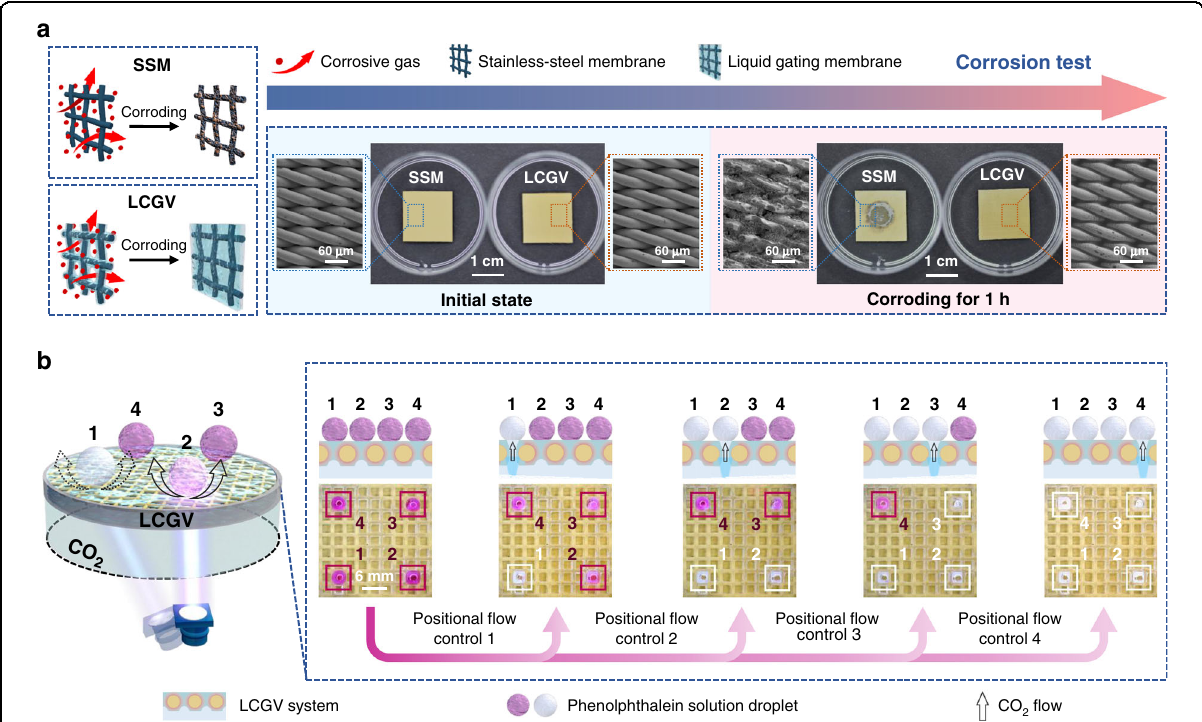
Fig. 4 Corrosion resistance of the LCGV system and its light-regulated gas valve application with non-thermal effective gating-liquid positional fl ow control. a Corrosion tests of SSM and LCGV system. b Non-thermal effective light-regulated positional gas-triggered reaction under a steady-state